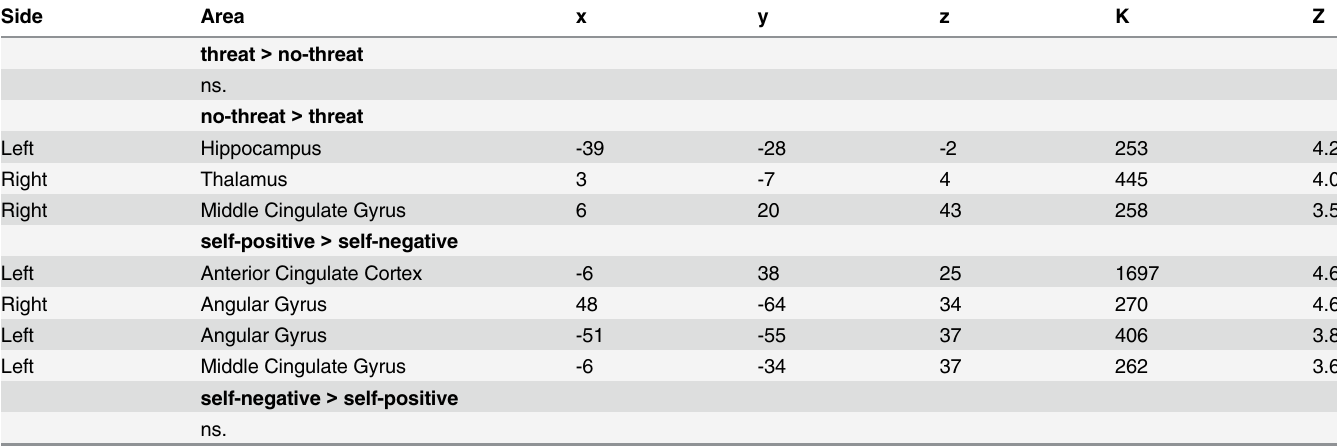
Table 5. Between-subjects group differences in activation: self-threat and no-threat activation (contrasts: threat > no-threat and no-threat > threat ); activation for positive self-related and negative self-related traits (contrasts: self-positive > self-negative and self-negative > self-positive ).